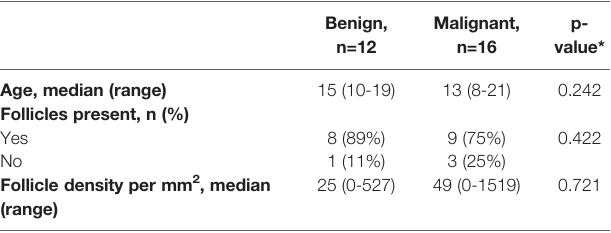
TABLE 2 | Ovarian tissue cryopreservation by indication.